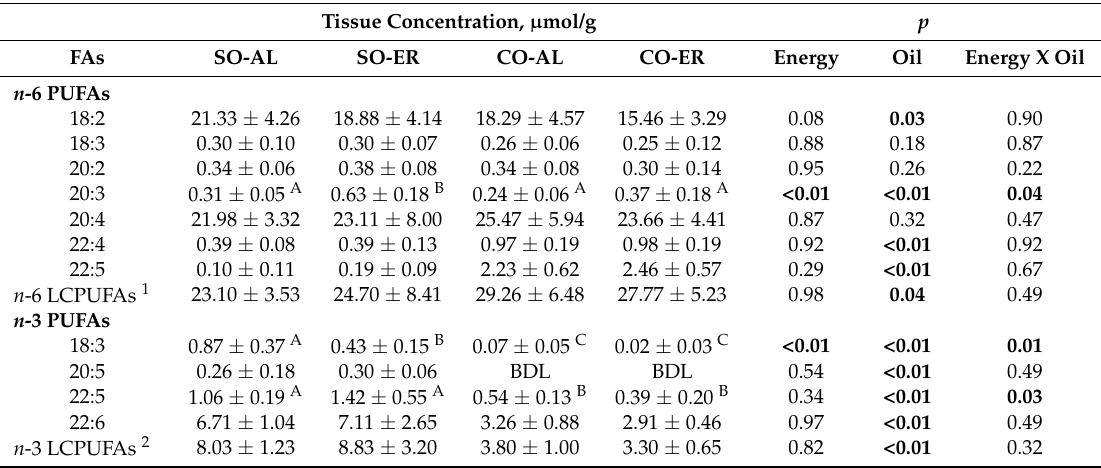
Table 3. Polyunsaturated fatty acid (PUFA) concentration in the liver of juvenile male rats. Tissue Concentration, µ mol/g